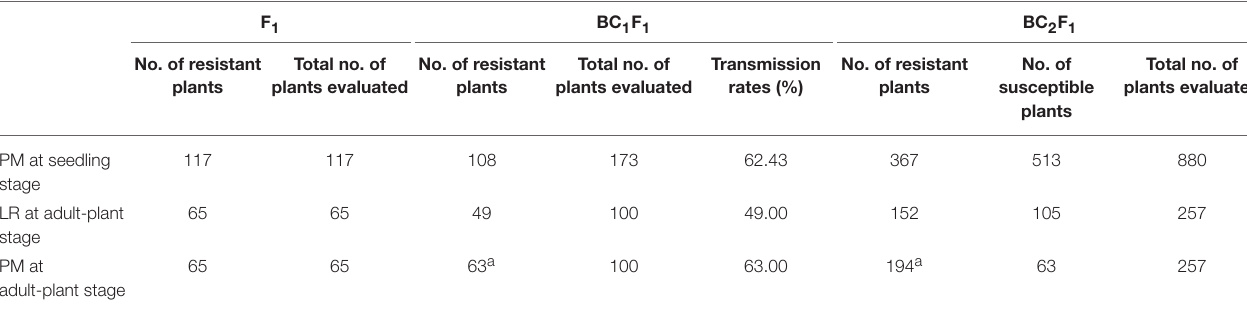
TABLE 1 | Inheritance of powdery mildew and leaf rust resistance in progeny.